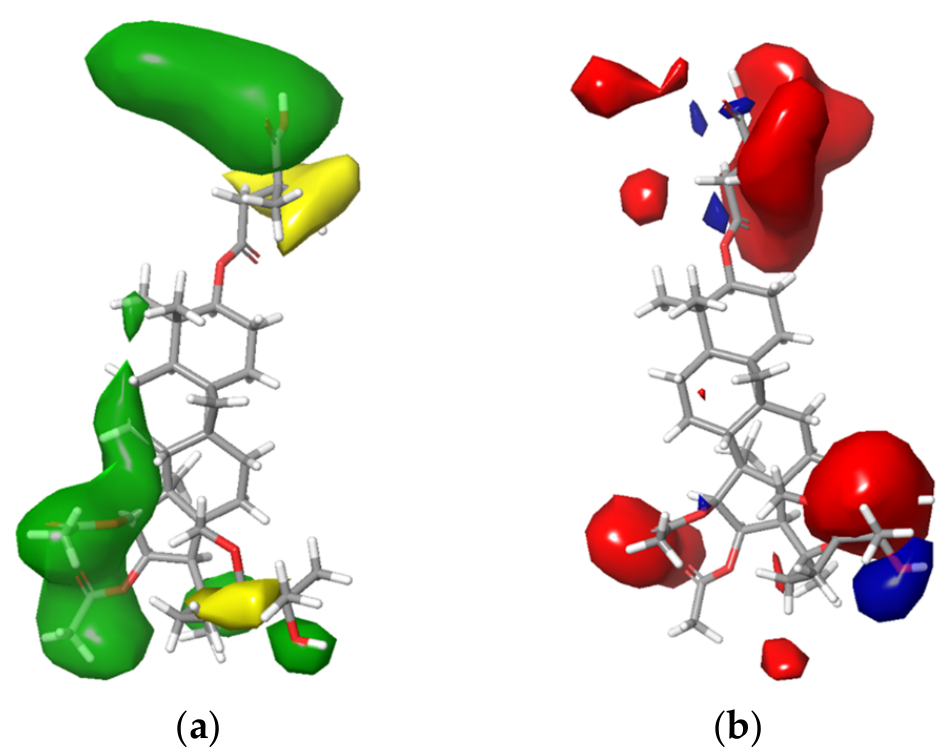
Figure 3. Steric contour map for 3D-QSAR. ( a ) Green represents positive coefficients and yellow negative coefficients. Electrostatic contour map for 3D-QSAR. ( b ) Blue represents positive coefficients and red negative coefficients.